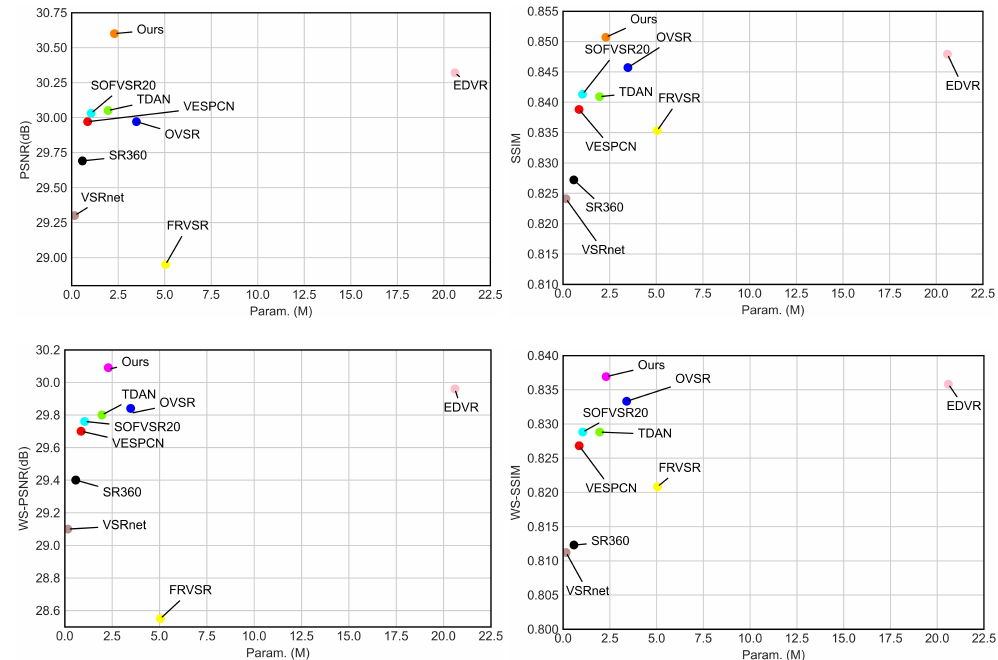
Figure 6. Comparison of all the methods in terms of performance and number of parameters. Note that the y -axis represents different performance metrics (including PSNR, SSIM, WS-PSNR, and WS-SSIM), and the x -axis corresponds to the number of parameters in different methods.